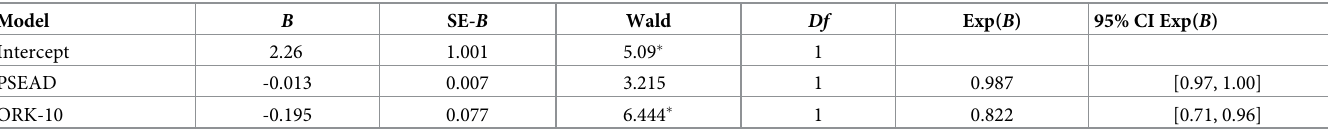
Table 6. Binary logistic regression results of multiple predictors of correct classification of child weight with Likert classification by parents.